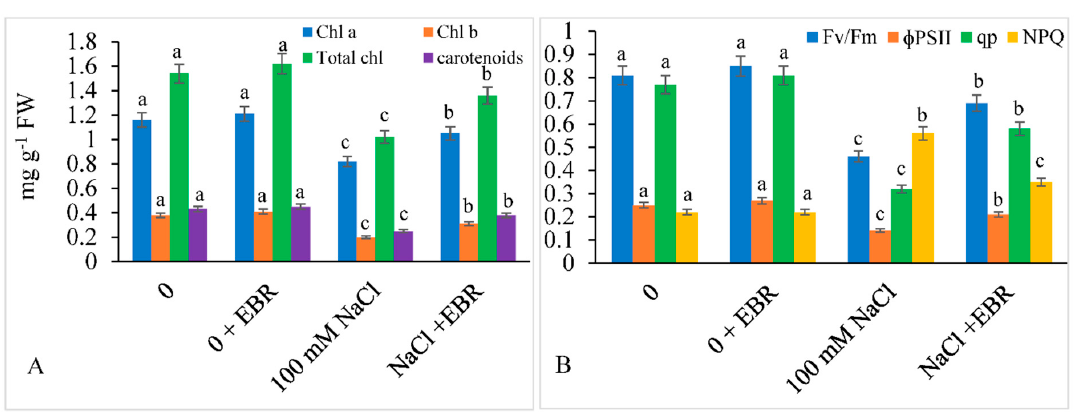
Figure 2. Effect of 24-epibrassinolide (EBR) on ( A ) pigment content and ( B ) chlorophyll fluorescence parameters under NaCl toxicity in soybean. Data presented are the means ± SE ( n = 5) and significant difference between the means calculated at p ≤ 0.05 using the Duncan’s multiple range test. The gas exchange parameters such as CO 2 assimilation rate ( A ), transpiration rate ( E ), and stomatal